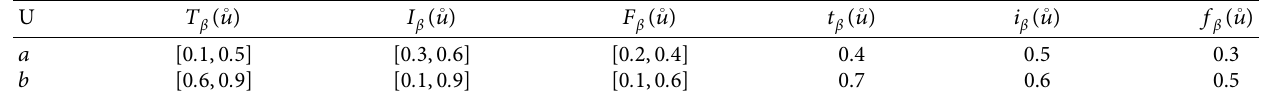
Table 8: Neutrosophic cubic set β of U.